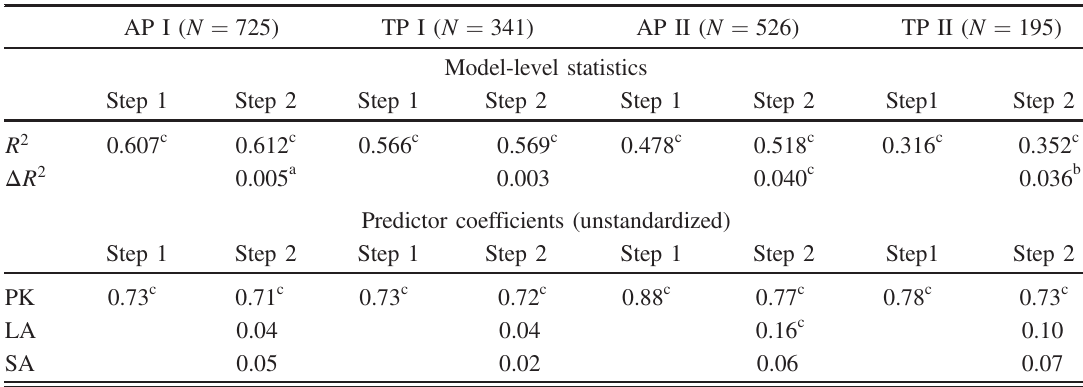
TABLE VI. Regression-model summaries predicting late-semester concept inventory (FCI and BEMA) scores from prior knowledge measures and CLASS factors from our two-factor solution. Fall Active Physics (AP I); Fall Traditional Physics (TP I); Spring Active Physics (AP II); Spring Traditional Physics (TP II); number of observation ( N ); change in R 2 between step 1 and step 2 ( Δ R 2 ); prior knowledge (PK) (FCI in AP I and TP I, BEMA in AP II and TP II); Learning Approach (LA); Solving Approach (SA). Prior knowledge alone was entered in step 1 of each model, and the two CLASS factors were added in step